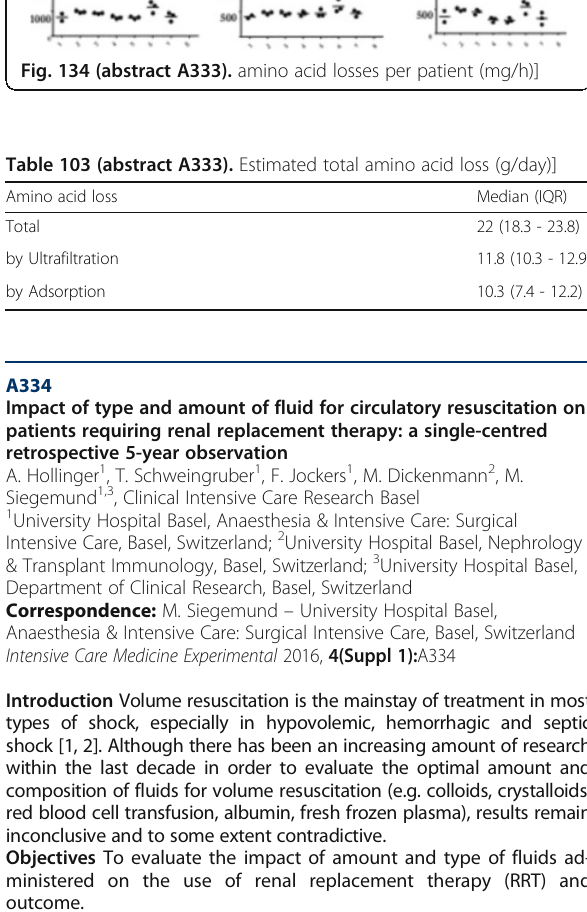
Table 103. The sieving coefficients of most amino acids were near 1. Sieving co- efficients of glutamic acid (0.60), taurine (0.83), tryptophan (0.84) and ornithine (0.85) were lower. Conclusion During CVVH with a modern polysulfone mem- brane, the estimated amino acid loss is 22.0 g/day. Total loss